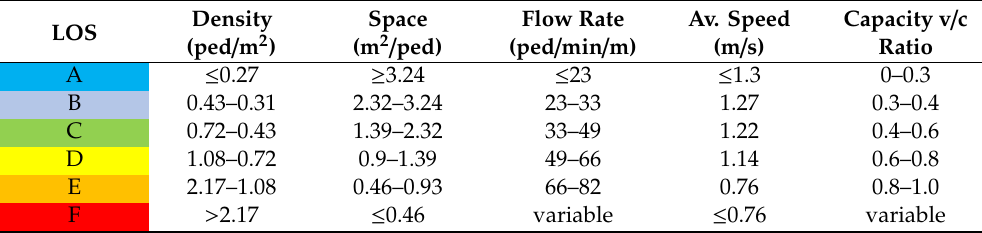
Table 7. LOS values in accordance with Fruin model.